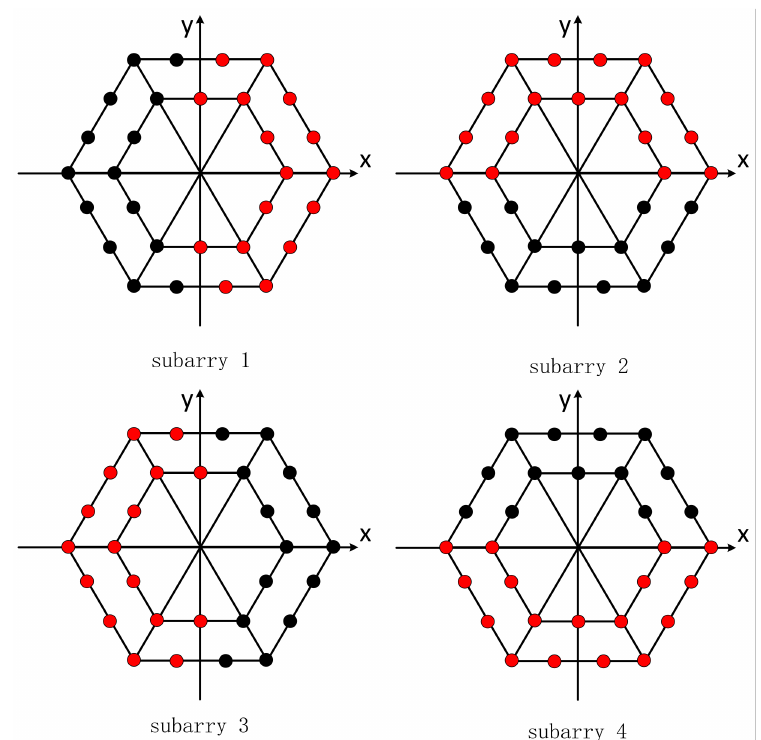
Figure 10. Virtual subarray.